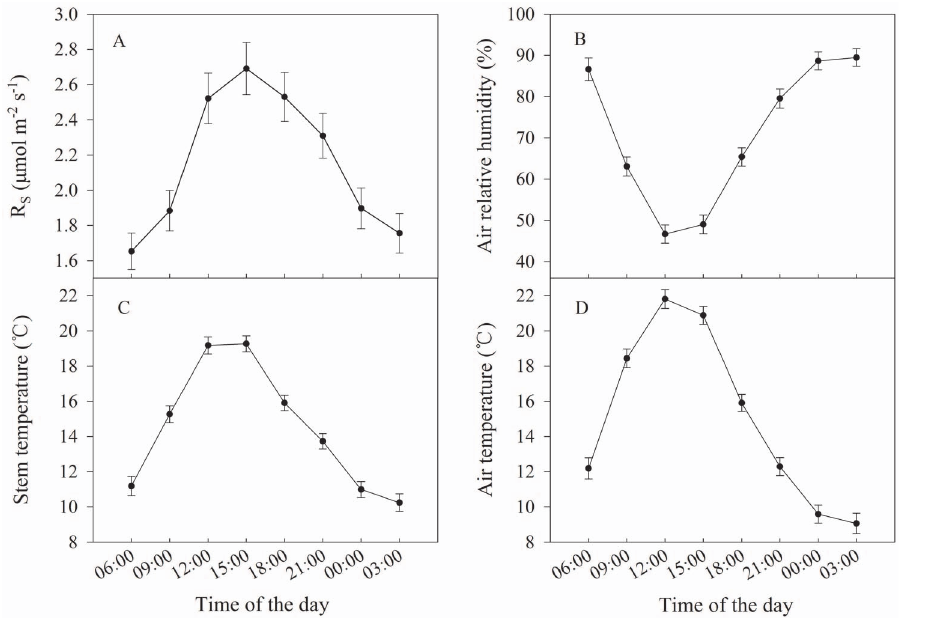
Figure 2. Diurnal changes in (A) stem respiration per unit surface area (RS), (B) air relative humidity, (C) stem temperature and (D) air temperature. For each 3-hourly interval, measurements were averaged for the six sample trees in the whole growing season (May to Sep) from 2010 to 2012. The resulting standard errors are represented by the bars.